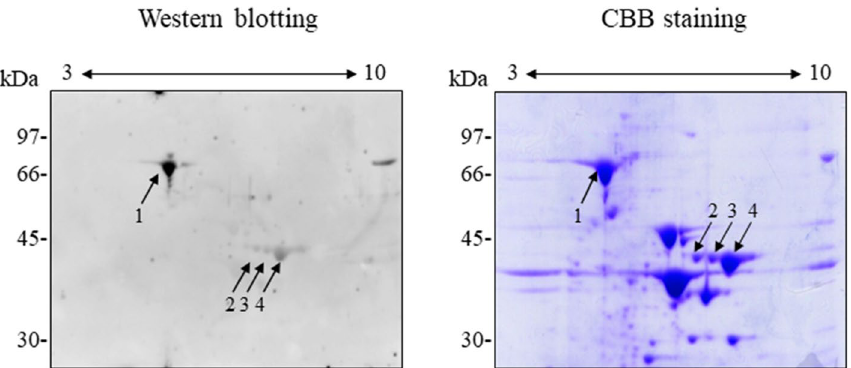
Figure 3. 2D-PAGE and immunoblot analysis of two putative allergens from L. vannamei . Samples of the Tris- soluble protein fraction (100 μg) were separated by 2D-PAGE and either stained with CBB or immunoblotted with a 1:10 dilution of serum from shrimp-FDEIA patient no. 1. Arrows indicate the dominant IgE-binding proteins. A full-length blot and a gel are presented in Supplementary Figure S3.